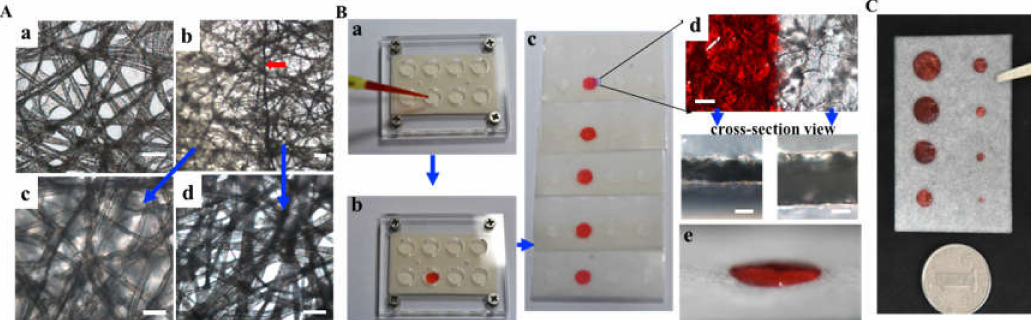
Figure 2. Parafilm®patterned lens paper for assembling of multi-layer paper based cell culture